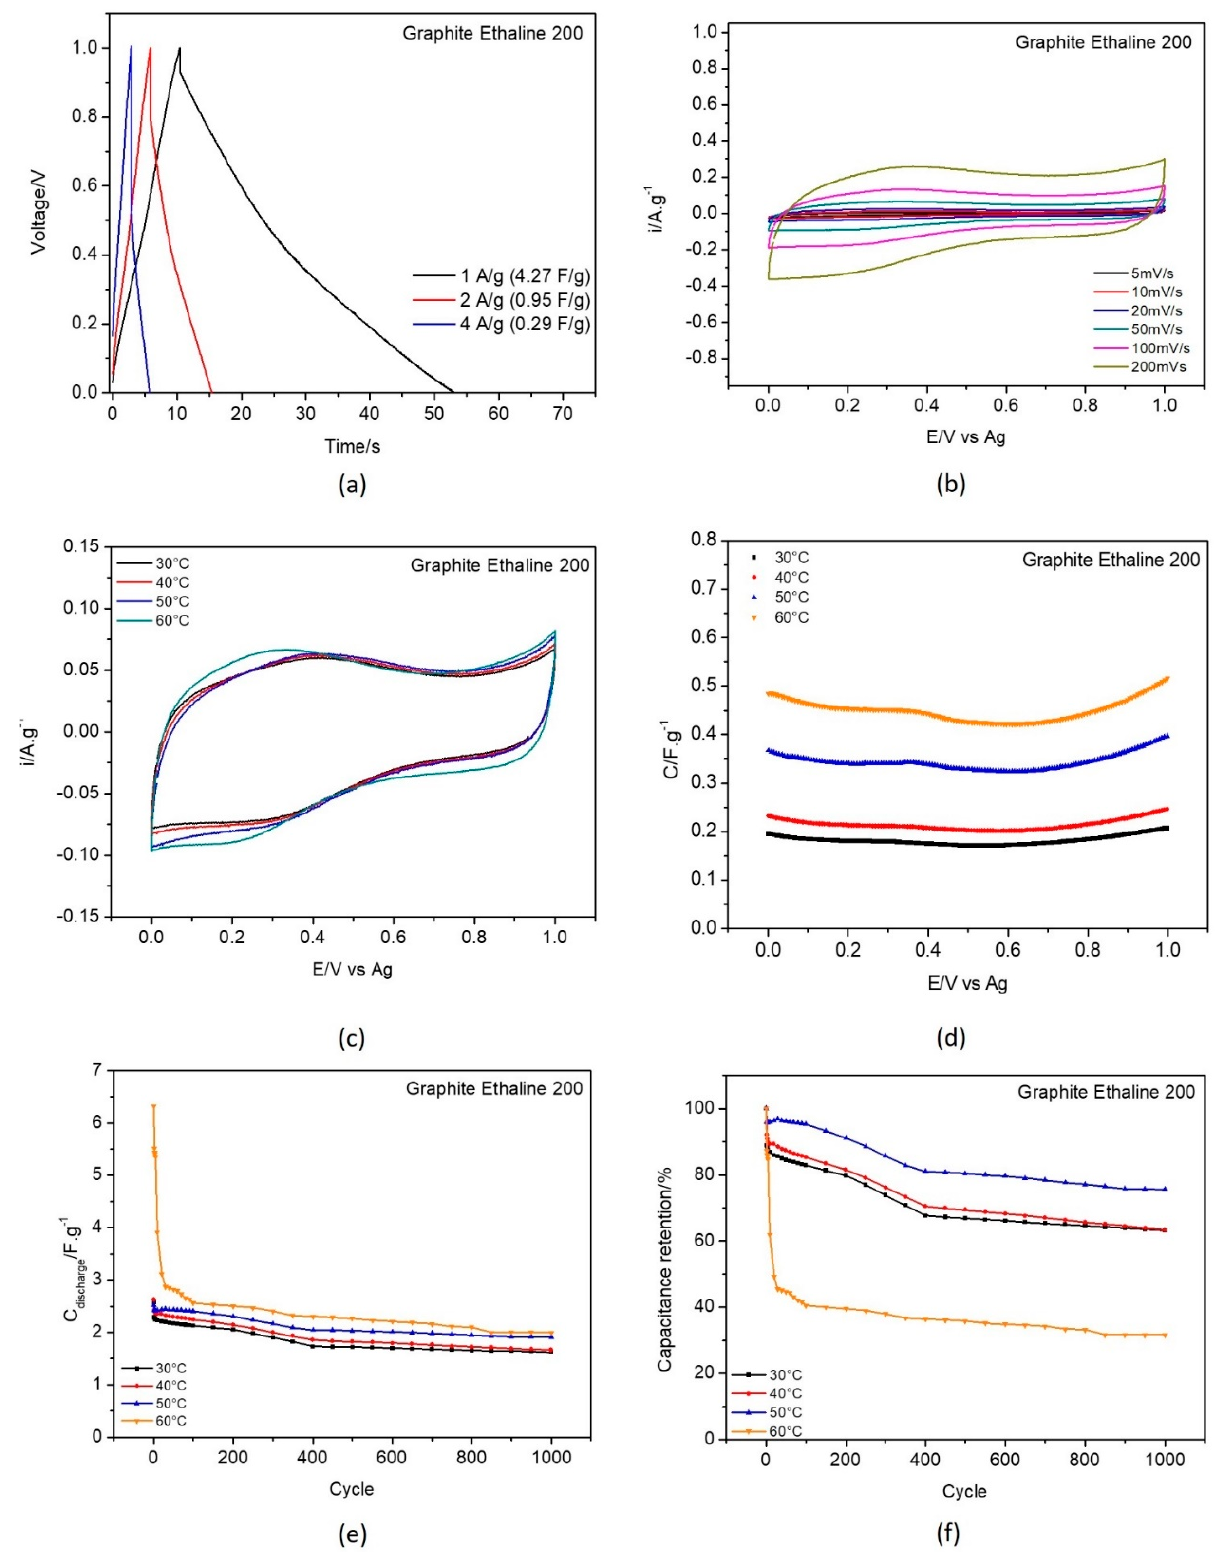
Figure 7. Electrochemical testing of commercial graphite in E200 electrolyte: ( a ) galvanostatic charge − discharge curves recorded with current density 1, 2 and 4 A·g − 1 at 30 °C; ( b ) CV curves recorded at scan rates 5, 10, 20, 50, 100 and 200 mV.s − 1 at 30 °C, temperature effect on ( c ) cyclic voltammetry at 50 mV.s − 1 ; ( d ) capacitance − potential curve; ( e ) discharge gravi- metric capacitance for 1000 cycles; and ( f ) capacitance retention.